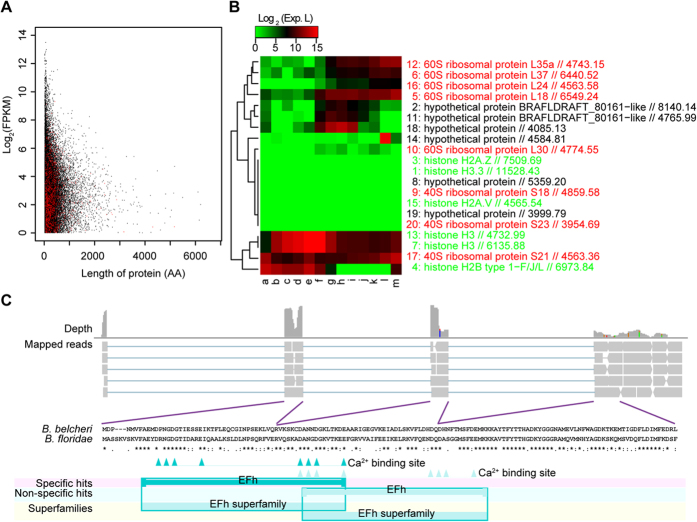
Overview of the transcriptome of amphioxus.(A) Distribution of the abundance of transcripts and the length of encoded proteins. The abundance of transcripts was calculated as FPKM with un-normalized RNA-Seq data. Transcripts that code for transcription factors are highlighted in red. (B) Heatmap showing expression patterns of top 20 highly expressed transcripts. Gene names are coloured according to their functions: red, ribosomal proteins; green, histone; black, hypothetical proteins. Values after gene names indicate the FPKM, which was estimated by Tophat-Cufflinks with un-normalized RNA-Seq data. Because they lacked a restriction site for the restriction enzyme NlaIII, the expression levels of several transcripts were not detectable across all stages by using DGE-Seq. a-m represent different developmental stages: a. egg, b. 2 cells, c. 16 cells, d. 64 cells, e. 128–256 cells, f. gastrula, g. neurula, h. hatch, i. 12 hours after hatching, j. 24 hours, k. 48 hours, l. male adult and m. female adult. (C) Features of a potential novel protein encoded by the transcript with highest expression level. Upper panel: alignment of RNA-Seq data on the amphioxus genome. Middle panel: pairwise alignment results of this protein with its counterpart in B. floridae. Lower panel: Domain structure of this protein.